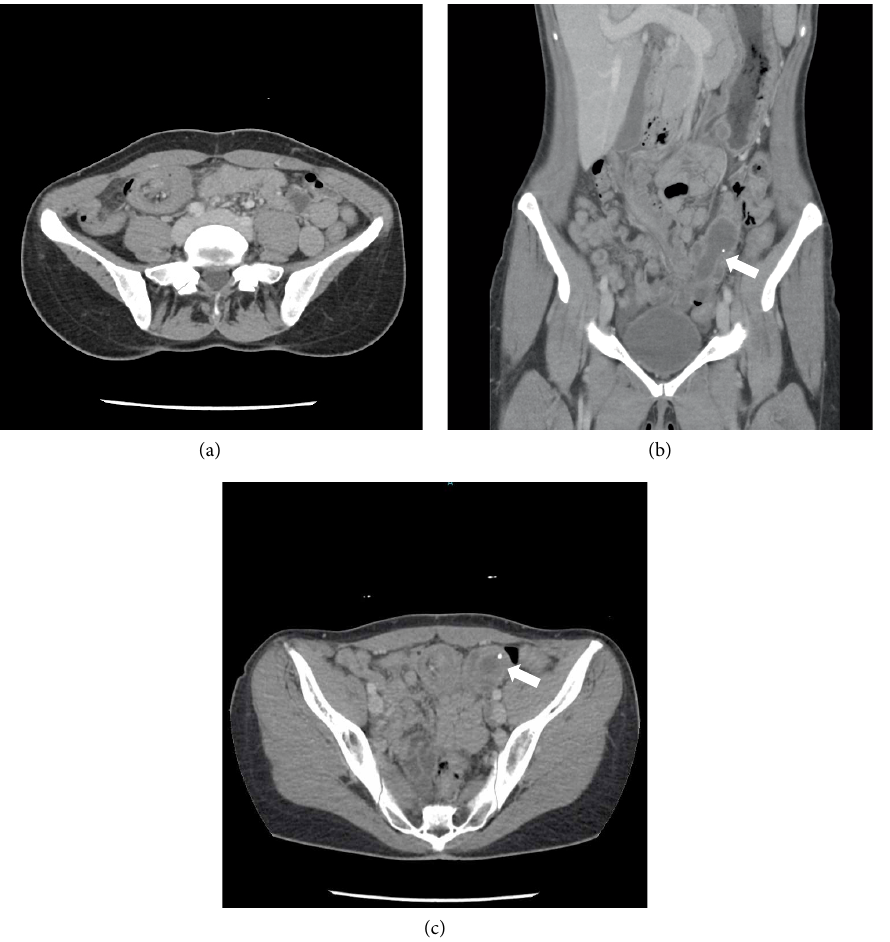
Figure 1: Axial and coronal CT images showing intussusception with the appendix indicated by the presence of a distended fluid-filled tube and an appendicolith